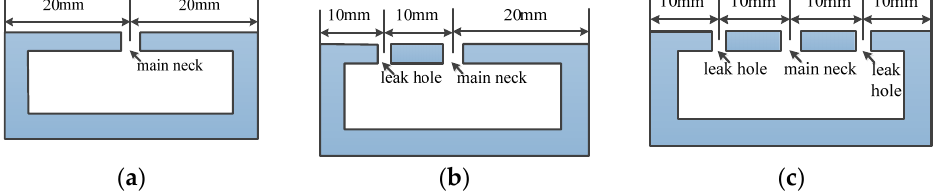
Figure 2. The locations of the main neck and the leak holes used in simulations; ( a ) No leak hole; ( b ) One leak hole; ( c ) Two leak holes.